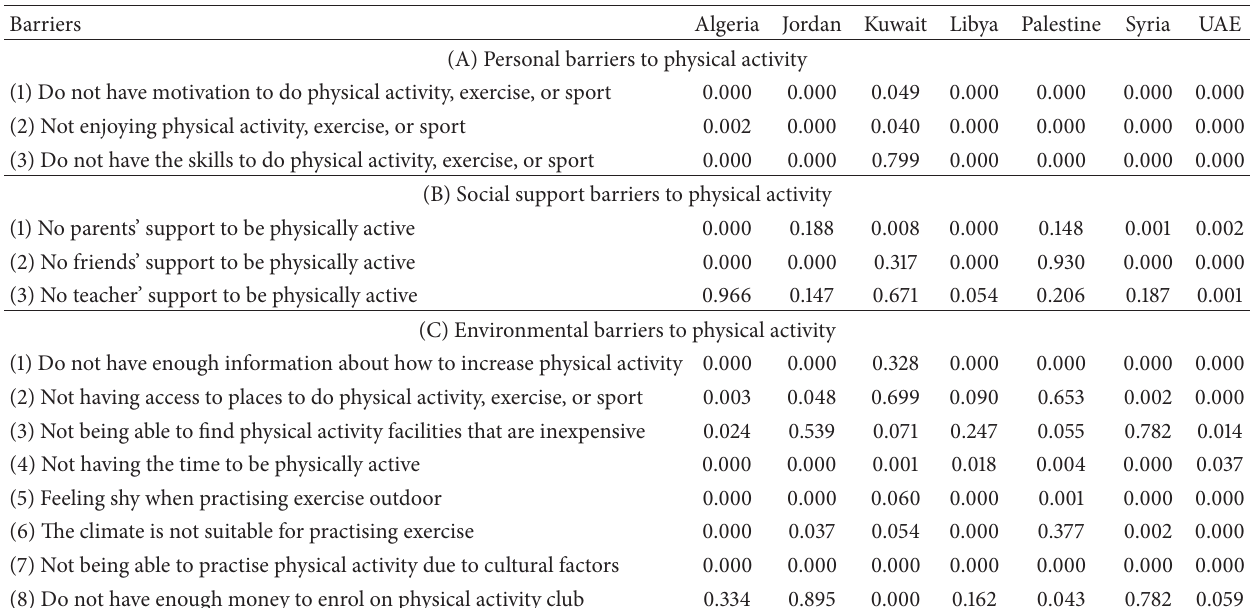
Table 6: Significant differences ( 𝑃 value) between males and females for perceived barriers to physical activity among Arab adolescents (using chi-square test).